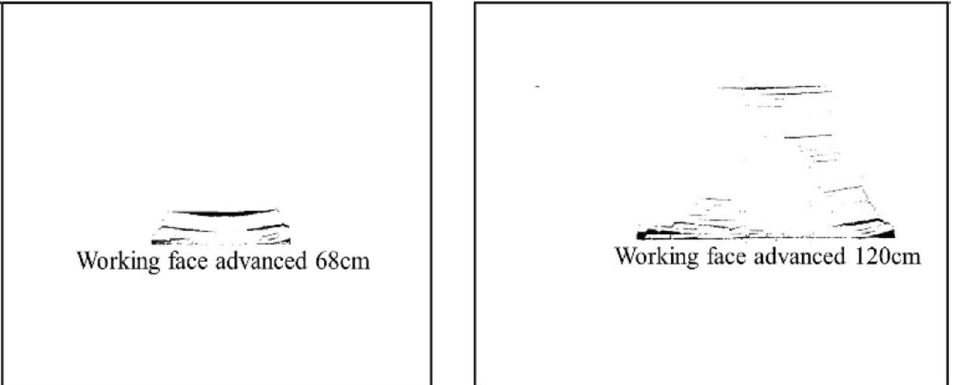
Figure 6. Binary diagram of 2–2 coal seam mining fissure